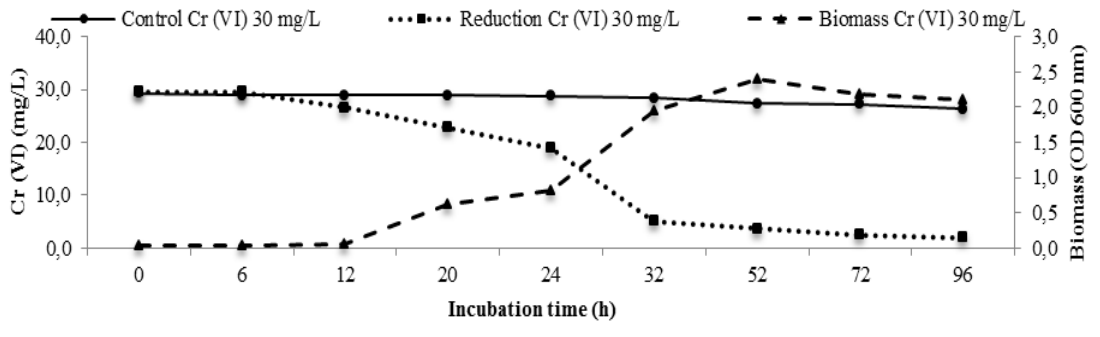
Fig. 5. Reduction capacity of Enterobacter sp. HT1 at 30 mg/L of Cr